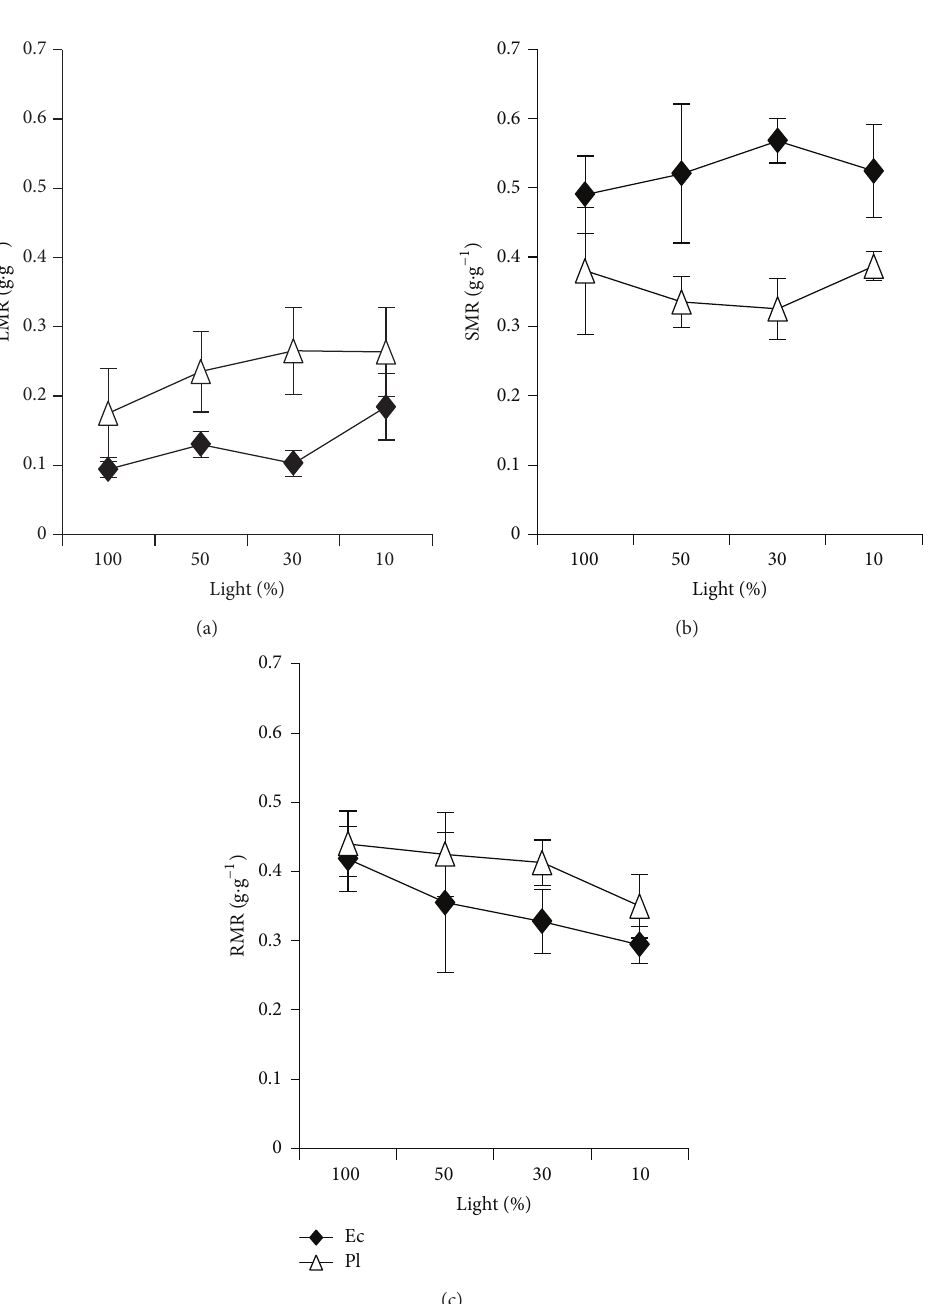
Figure 2: Biomass allocation responses to light for two rain forest tree species. Figures refer to (a) leaf mass ratio, (b) stem mass ratio, and (c) root mass